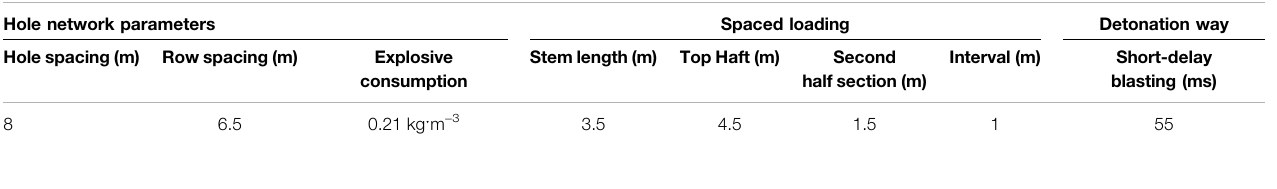
TABLE 9 | After optimization, blasting parameters. Hole network